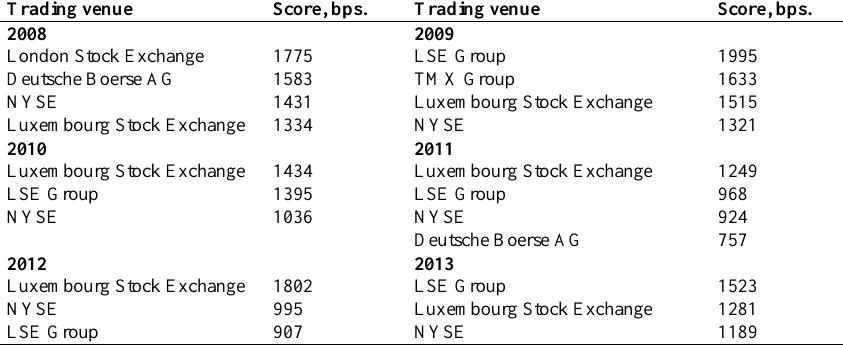
Table 7. Global systemically important trading venues for the “substitutability” category Trading venue Score,